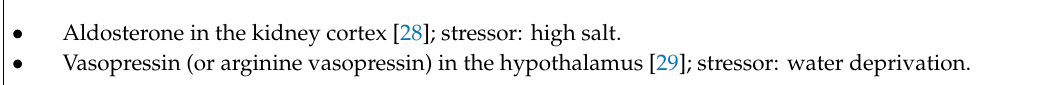
breaking down of fibrin into D-dimer. In the adrenal gland, Ang II/AT1R induces aldosterone secretion, which activates ENaC-dependent reabsorption of Na + into blood in exchange for K + in the kidney. NHE3 reabsorbs Na + from urine in exchange for H + . These transporters establish hypernatremia and hypokalemia in the blood. Hypoalbuminemia in blood compensates for cellular hypotonicity. Ang II/AT1R also stimulates arginin vasopressin (AVP), increasing stimulated thirst, while MAS remains inactivated. Ang II-centric events lead to hypertension treated with ACE inhibitors and AT1R blockers.